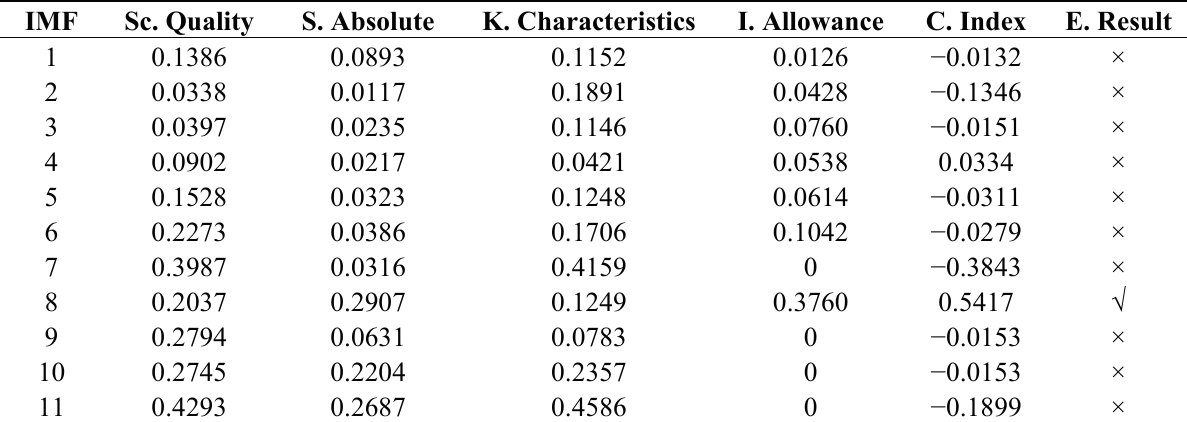
Table 4. IMFs’ confidence index calculation for the axle bearing vibration with cage fault.